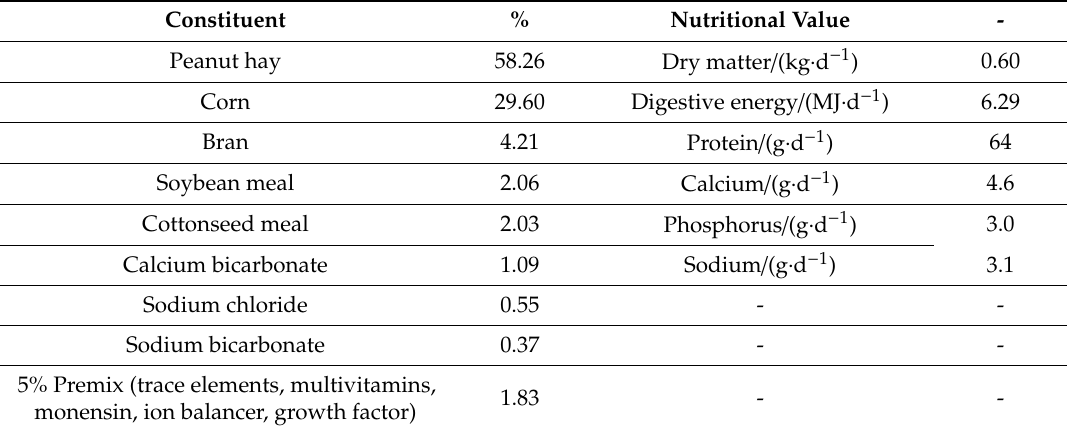
Table 1. The nutrient composition of the animal feed used in this study, expressed on an air-dry